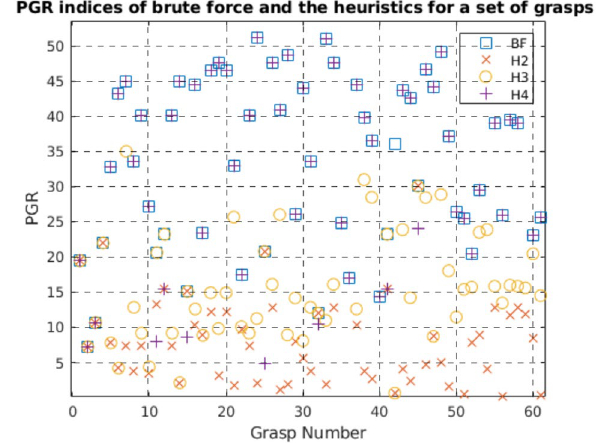
Fig. 5 PGR values for a set of 60 grasps exectued on two objects. Brute Force (BF) corresponds to the PGR index for all possible com- binations and Heuristics H2,H3 and H4 to the reduced set of con- tact point combinations